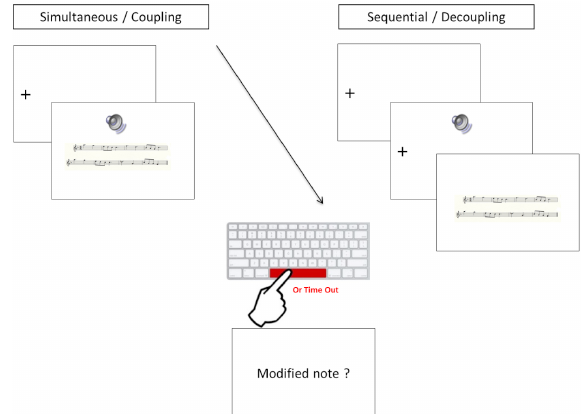
Figure 2. Design of the experimental procedure for the two conditions of auditory and visual excerpt presentation: (simultaneous/coupled and